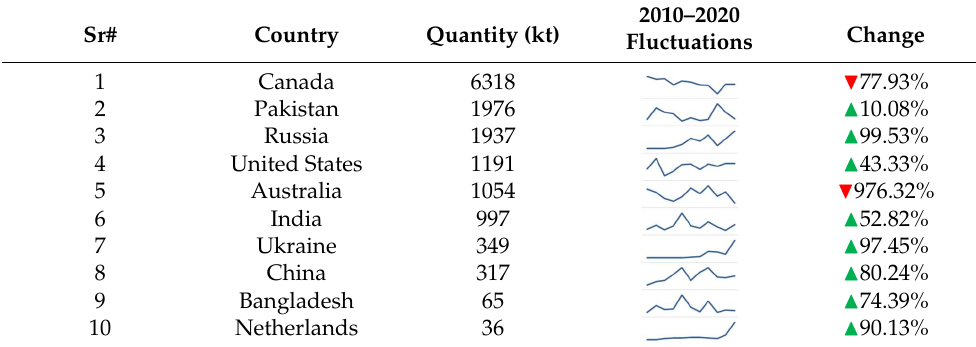
Table 2. Top ten importers of Sri Lankan crops based on last ten years (2010–2020). ( ▲ Positive change in imports from trade partners from 2010 to 2020, ▼ Negative change in imports from trade partners from 2010 to 2020).